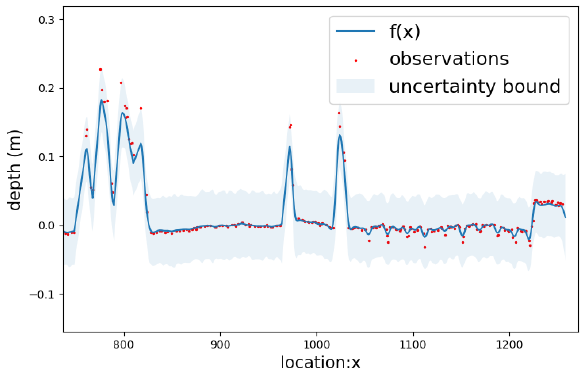
Figure 2. 1D example for the fac¸ade modelling: σ η = 2